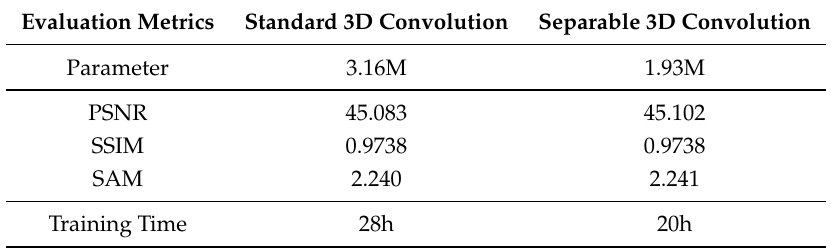
Table 7. Comparison of the performance of standard 3D convolution and separable 3D